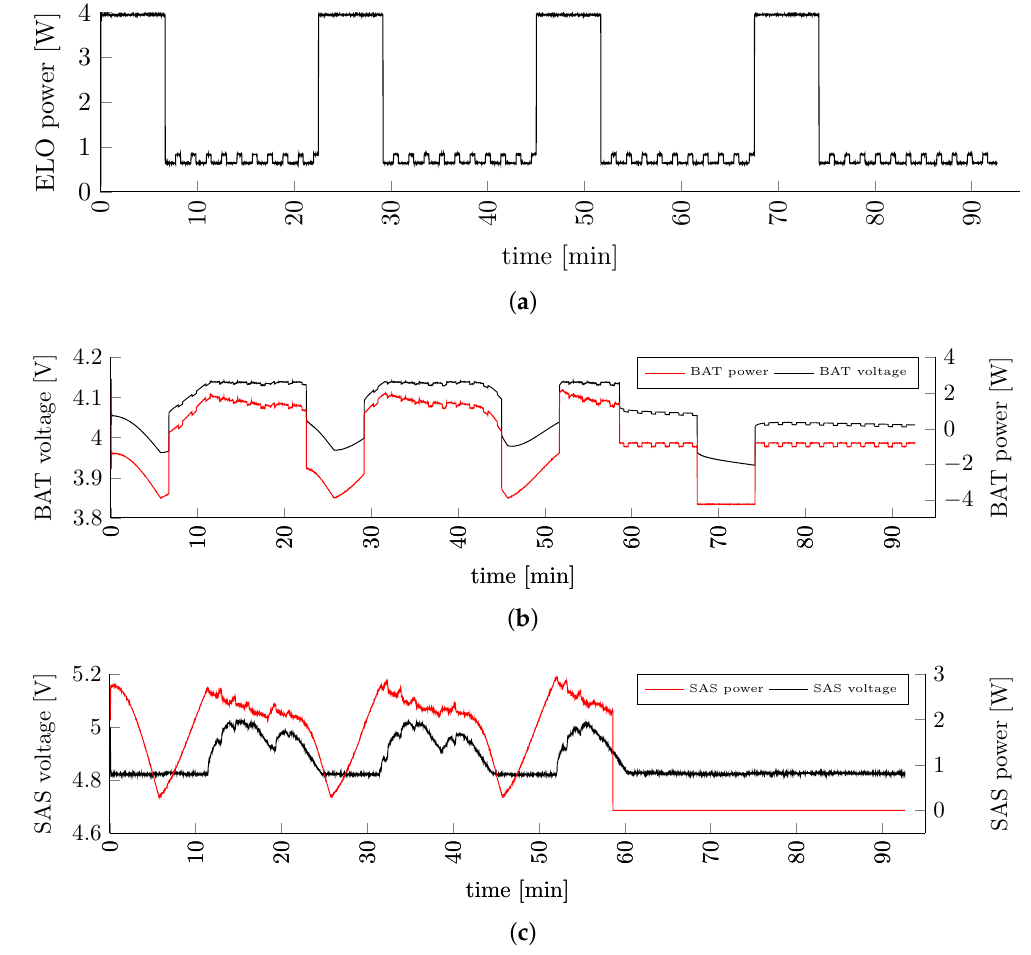
Figure 16. Excess energy: ( a ) ELO power; ( b ) SAS voltage; ( c ) BAT